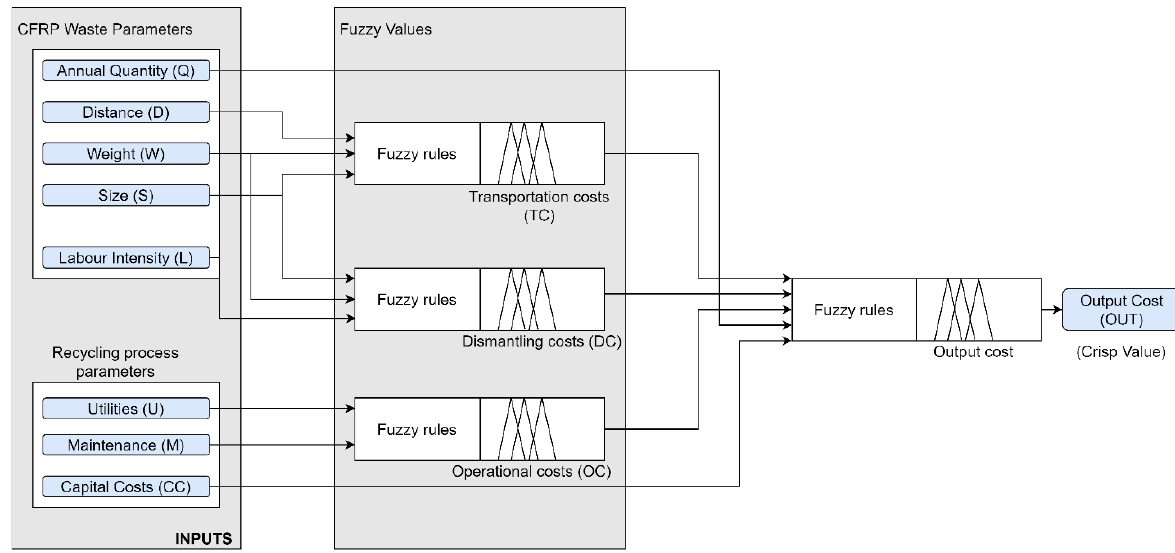
Figure 1. Architecture of the overall structure of the developed cost estimation system.